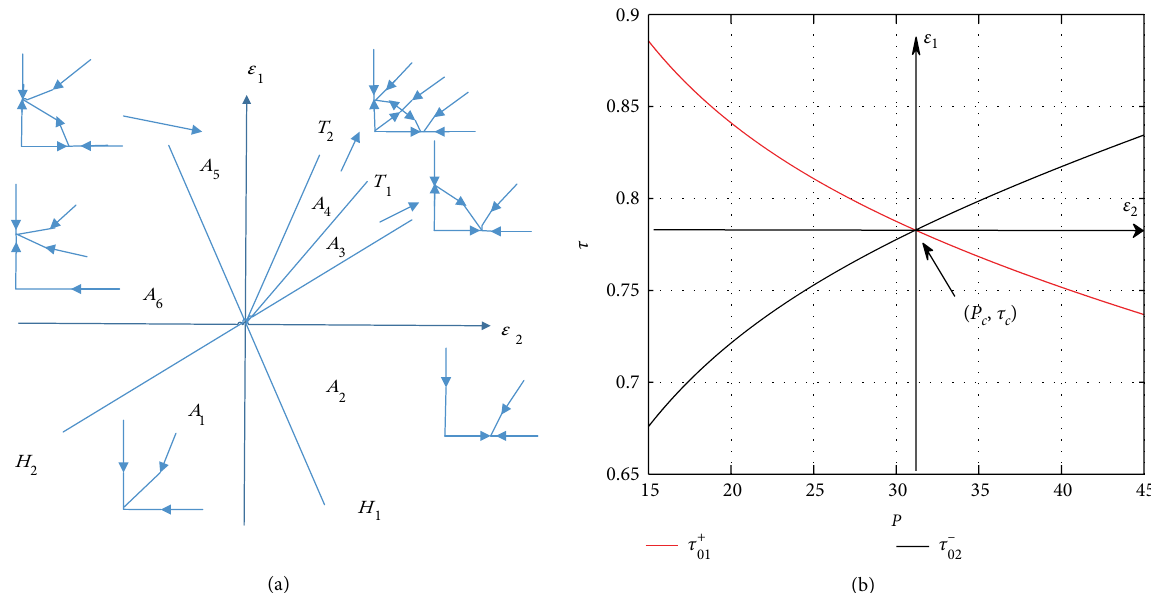
) ; and the corresponding phase portraits in the ( 𝑅 𝑐 , 𝜏 𝑐